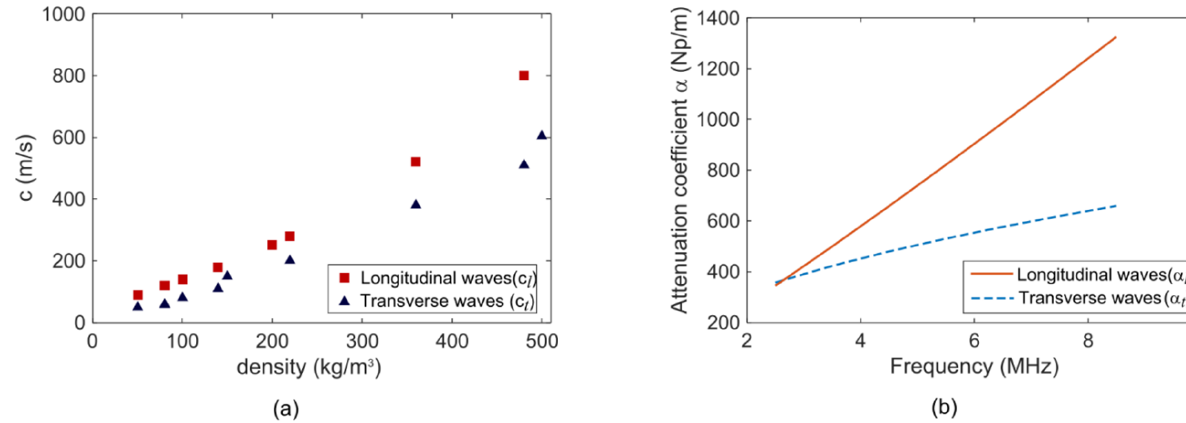
Figure 3. ( a ) Longitudinal ( c L ) and transverse ( c T ) sound speed in aerogel as a function of density. ( b ) Attenuation coef-